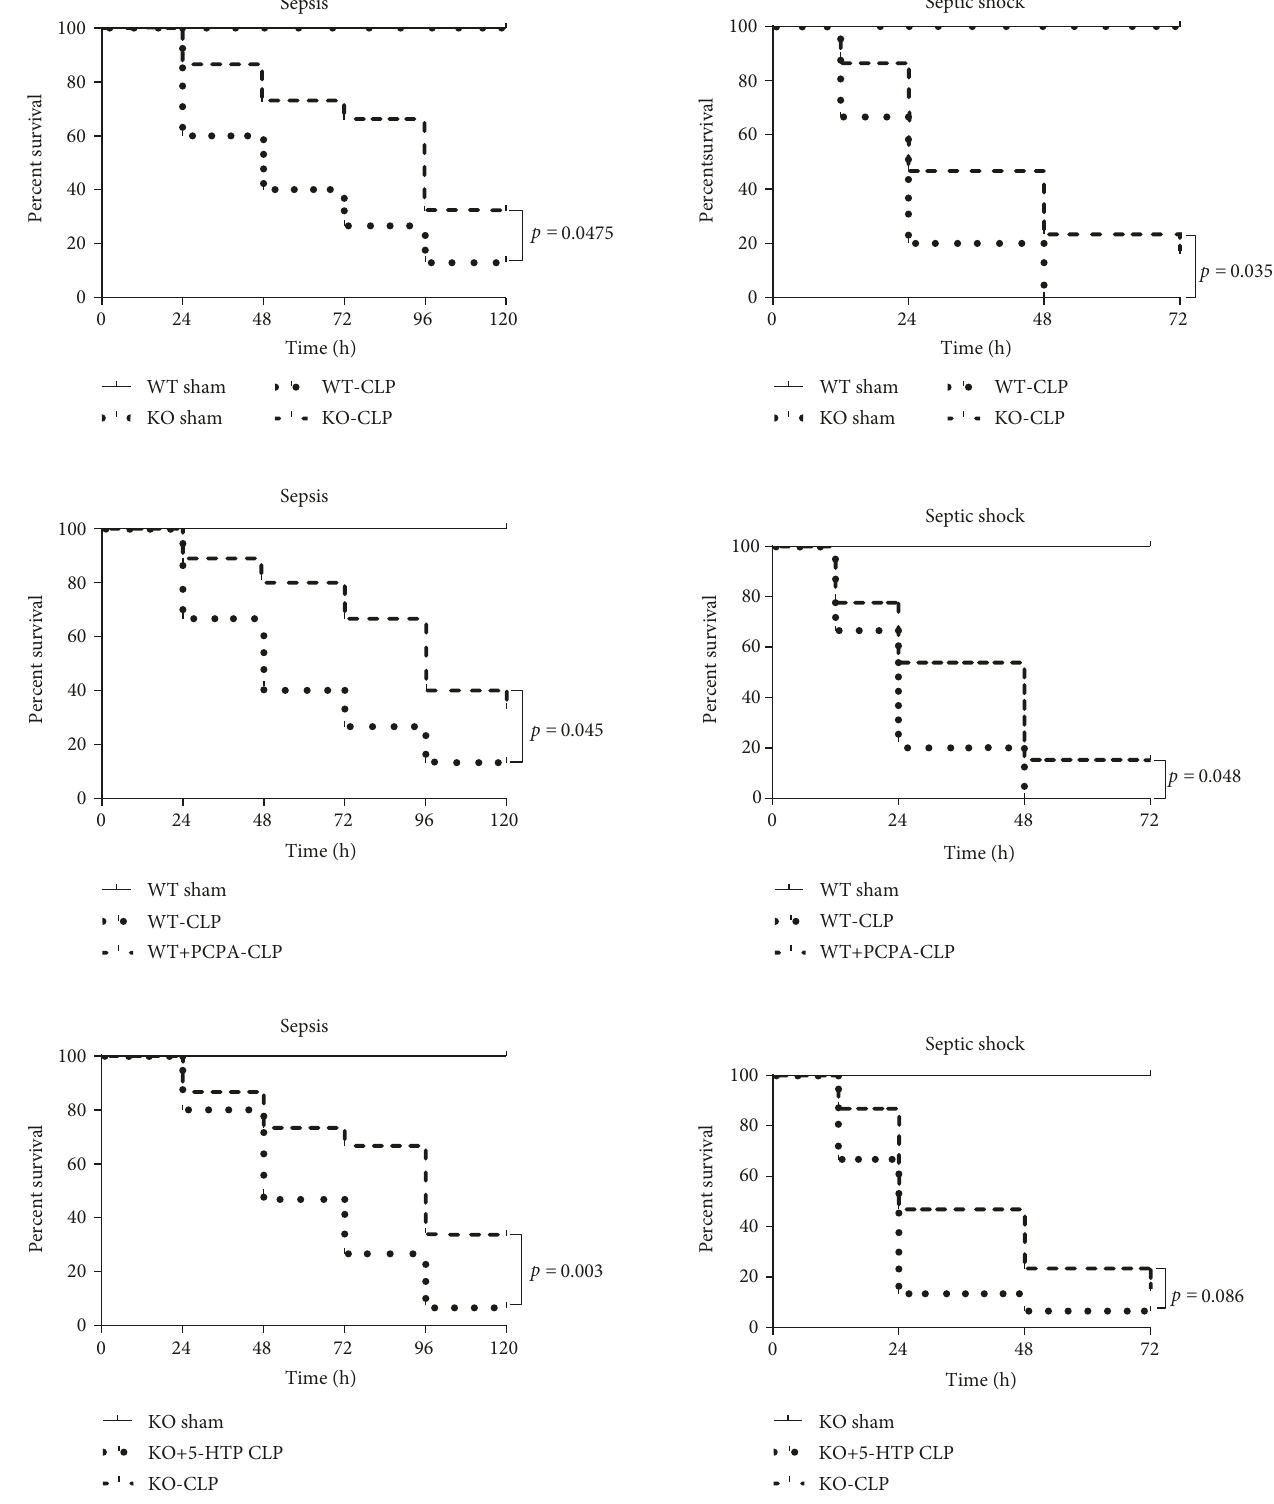
Figure 1: 5-HT drives the survival rate in a sepsis and septic shock model in mice. Kaplan-Meier survival curve for mice 5 days after the CLP sepsis model and 3 days after the CLP septic shock model. PCPA, a TPH1-inhibitor, at a dose of 150 mg/kg/day for 3 days by subcutaneous injection before the CLP. 5-Hydroxytryptophan (5-HTP), a precursor of 5-HT that can reload the 5-HT content, at a dose of 75 mg/kg/day for 3 days by subcutaneous injection before CLP). (WT sham group and KO sham group, n = 6 ; WT-CLP groups, KO-CLP groups, WT+PCPA- CLP groups or KO+HTP-CLP groups, n = 15 , p < 0 05 was statistically signi fi